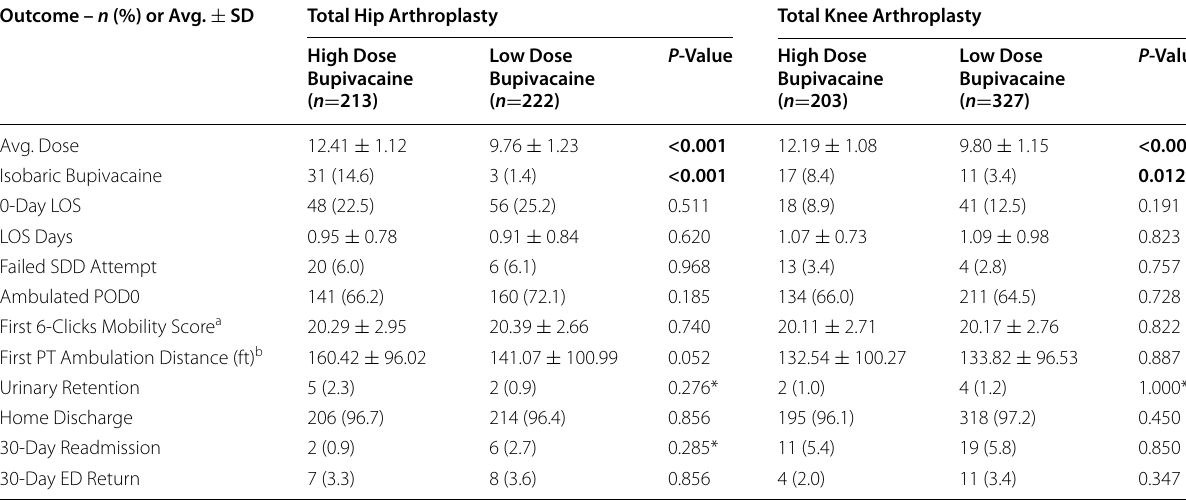
11 mg) bupivacaine ≥